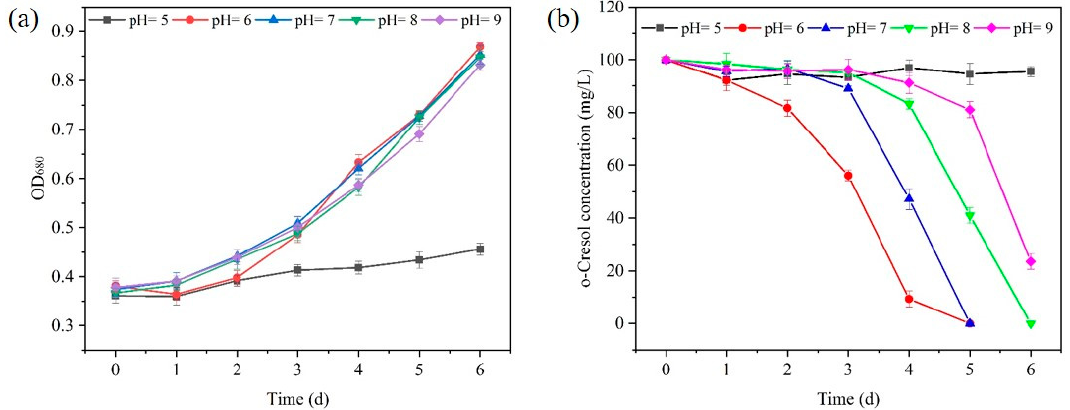
Figure 2. Growth of Selenastrum capricornutum and the degradation of o-cresol at different pH values. ( a ) Growth curve of Selenastrum capricornutum ; ( b ) degradation curve of o-cresol.